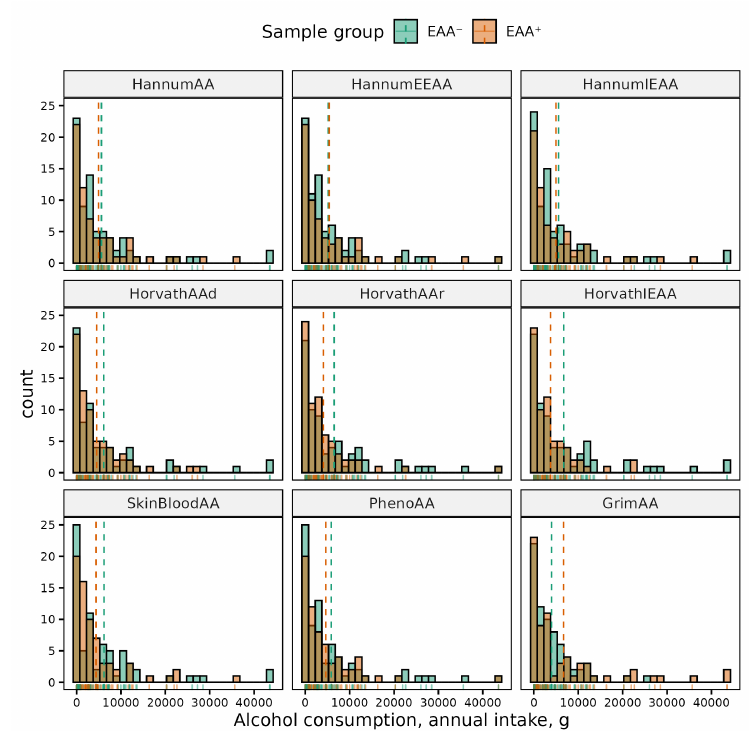
Figure A3. Histograms of distributions of annual alcohol consumption in males in EAA + and EAA − groups. Dashed lines correspond to the group means.